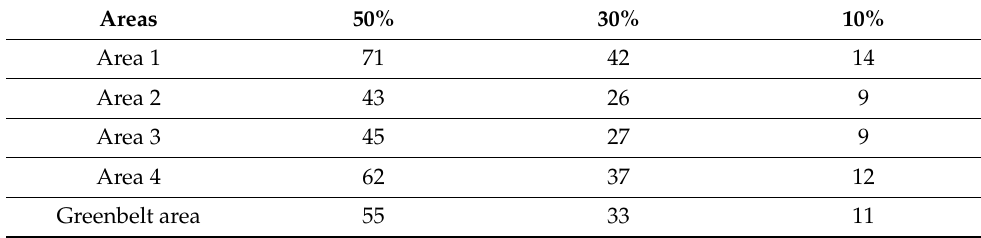
Table 7. Adjusted difference in land price (unit: USD